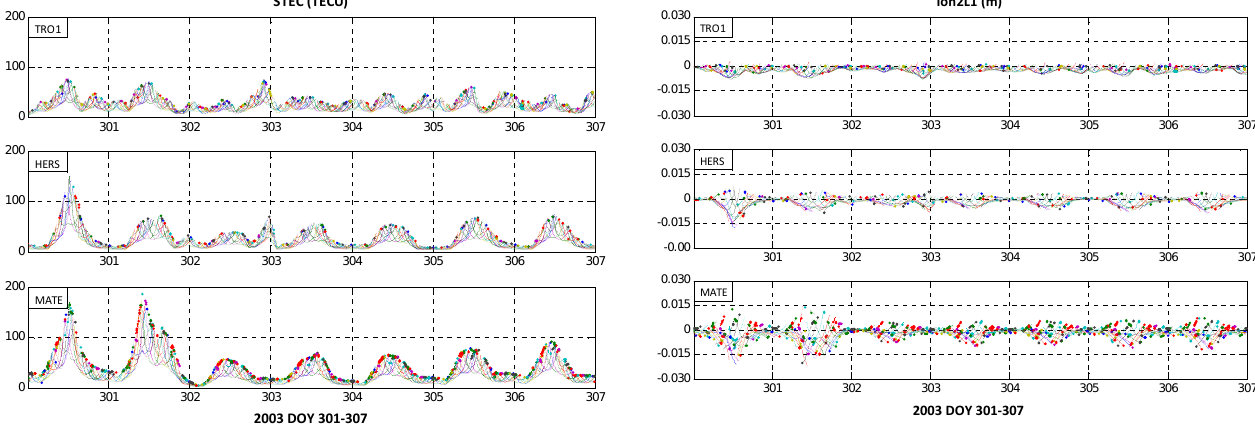
Fig. 8. STEC (TECU) for the observation stations on DOY 301‐307 in 2003.